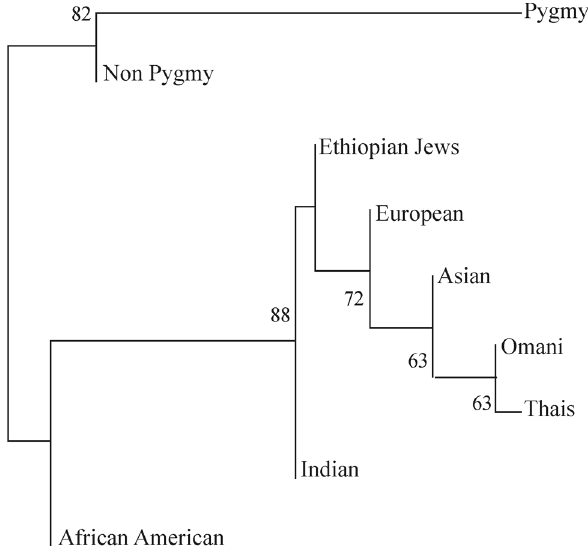
Figure 3 - Unrooted neighbor-joining tree constructed based on pairwise FST-corrected distances from CCR2-CCR5 haplotype frequencies. Num- bers at the nodes are bootstrap